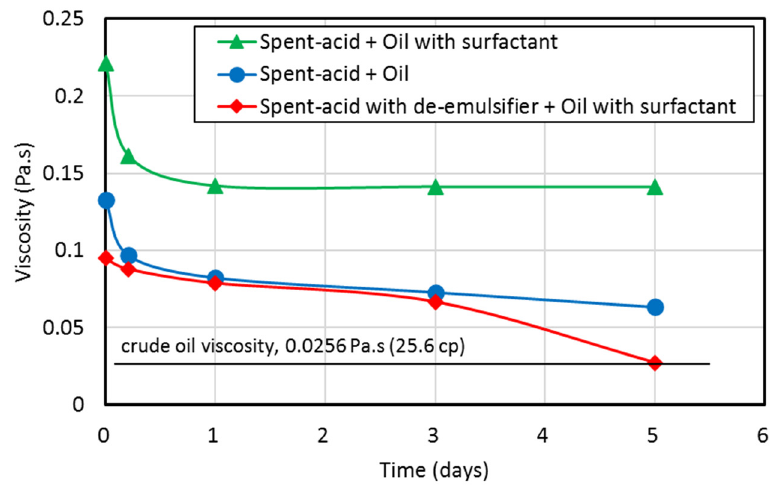
Figure 6. Spent-acid + Oil emulsion viscosity vs. time for the three scenarios.